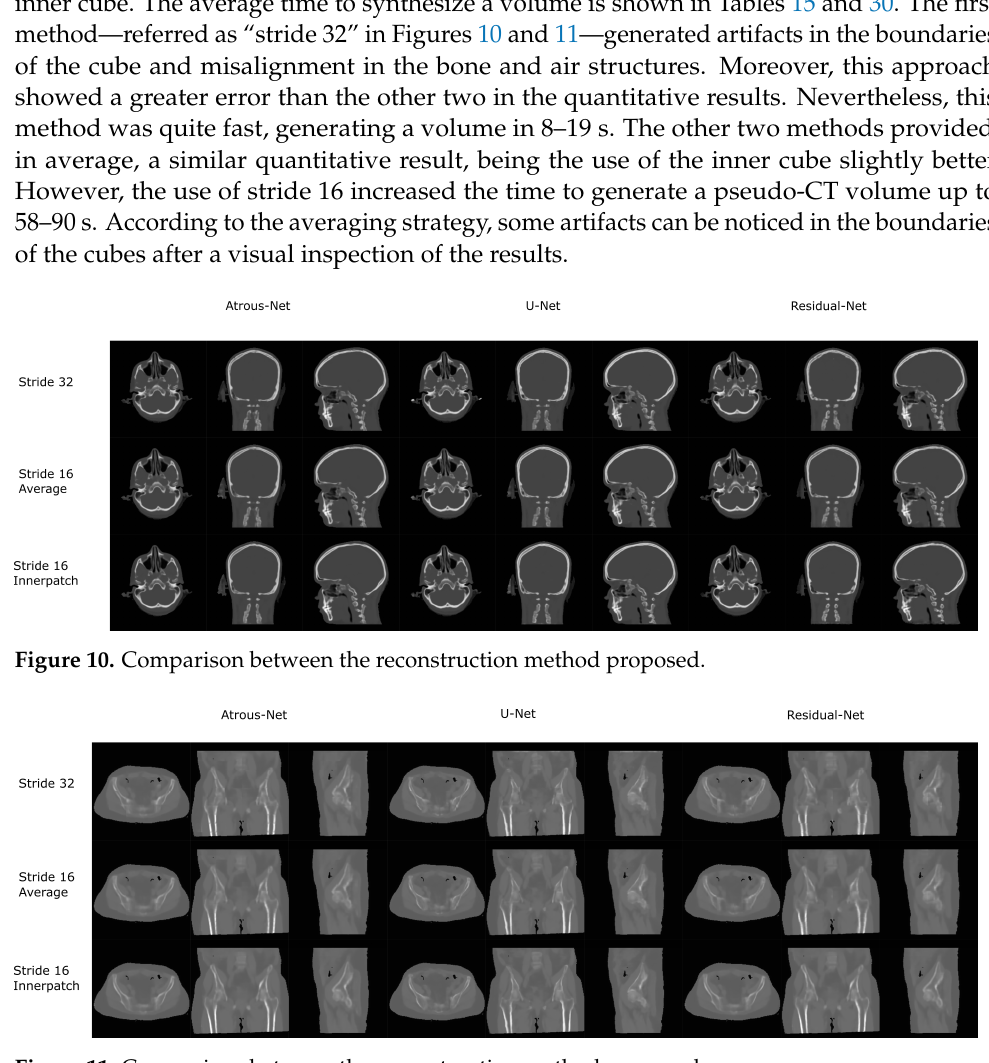
Figure 11. Comparison between the reconstruction method